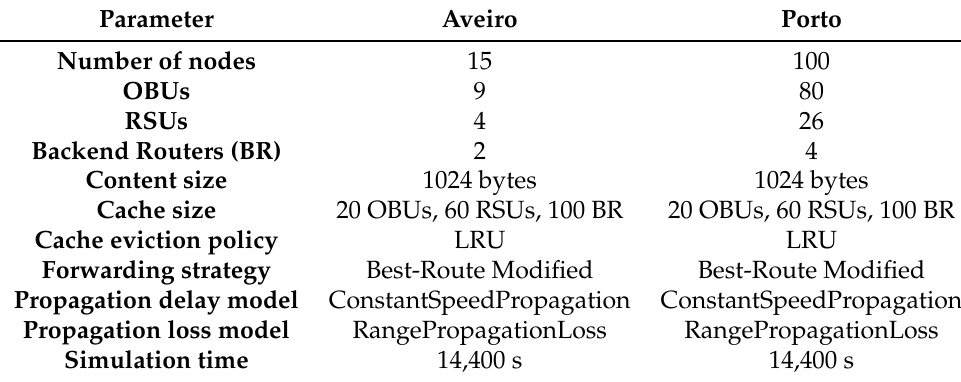
Table 1. Parameters used in the Aveiro and Porto mobile scenarios.